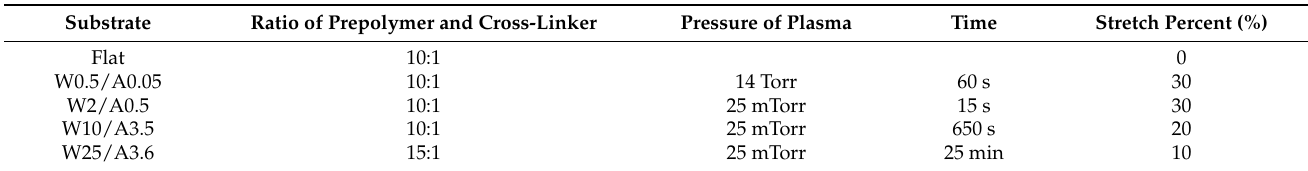
Table 1. Conditions for preparing aligned PDMS substrates of different sizes.